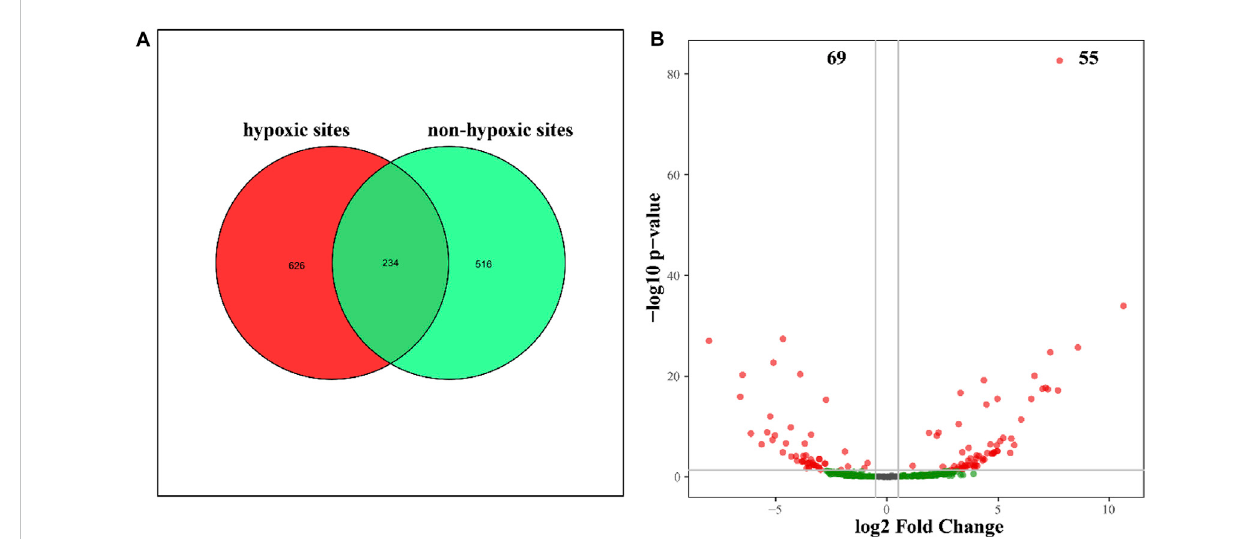
FIGURE 3 Unique and shared OTUs between the hypoxic and non-hypoxic zones. (A) Venn diagram showing the OTUs unique to the hypoxic (red) and non- hypoxic (green) zones and the shared OTUs (dark green). (B) Volcano plot showing the signi fi cant differences between enriched (red) and depleted (green) hypoxic OTUs.